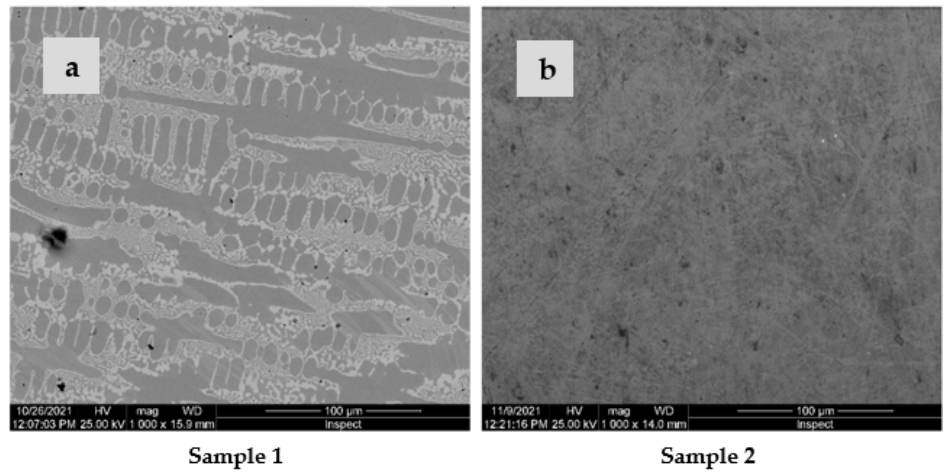
Figure 9 . SEM image of the surface after performing the corrosion tests: ( a ) Sample 1 and ( b ) Sample